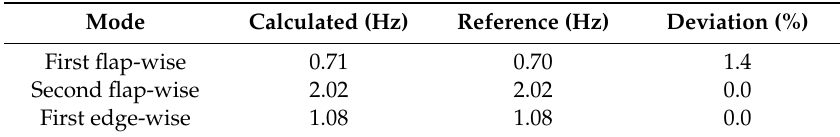
Table 1. Natural frequencies of the blade.